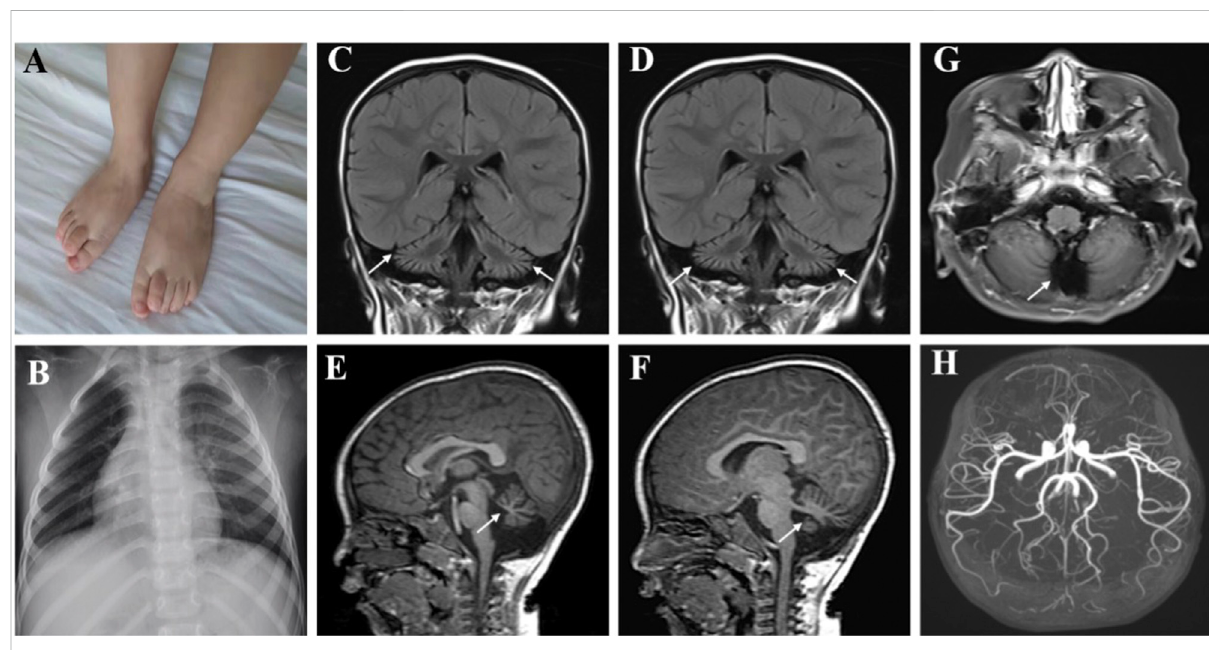
FIGURE 1 Clinical features of the patient with MSTO1 variant. The second toes of both feet were upward deformity (A) . Chest radiograph showed increasedbrightnessoftherightlung,hyperventilation wasconsidered (B) . (C – F) BrainMRIrevealedreducedcerebellarvolume, deepenedsulciand fi ssures, and narrowed gyri, the fourth ventricle and occipital cisterna were enlarged (G) . MRA was normal (H)